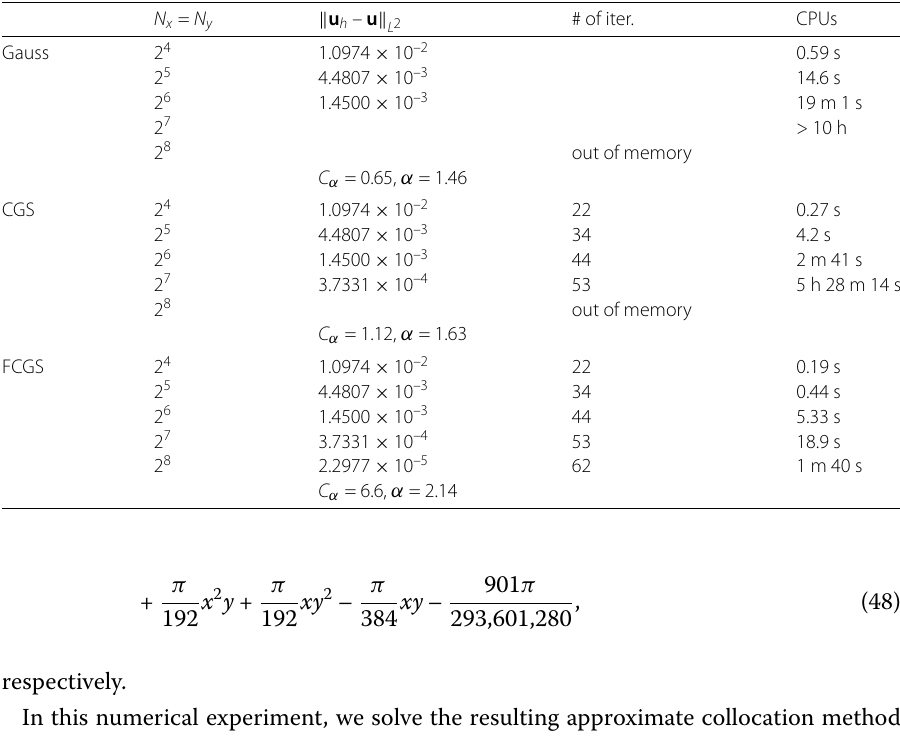
Table 3 Performance of FCG, CG, and Gauss while s = 0 N x = N